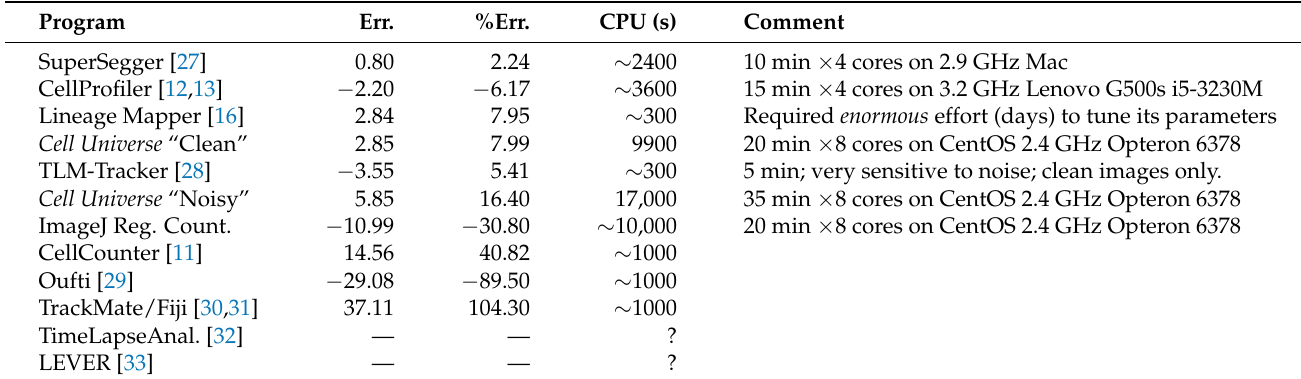
Table 1. Absolute and relative bacteria count errors for each tested program compared to manual counts, sorted best to worst. A “—” indicates that we were unable to get the program to work on our video. Note: CPU times for all programs other than Cell Universe are only approximate, because each program used its own specific environment (MacOS, Windows, Linux, Matlab, with or without a GUI, etc.). Thus, these tests were run on a highly heterogeneous set of machines with various amounts of RAM, cores, CPU clock speeds,